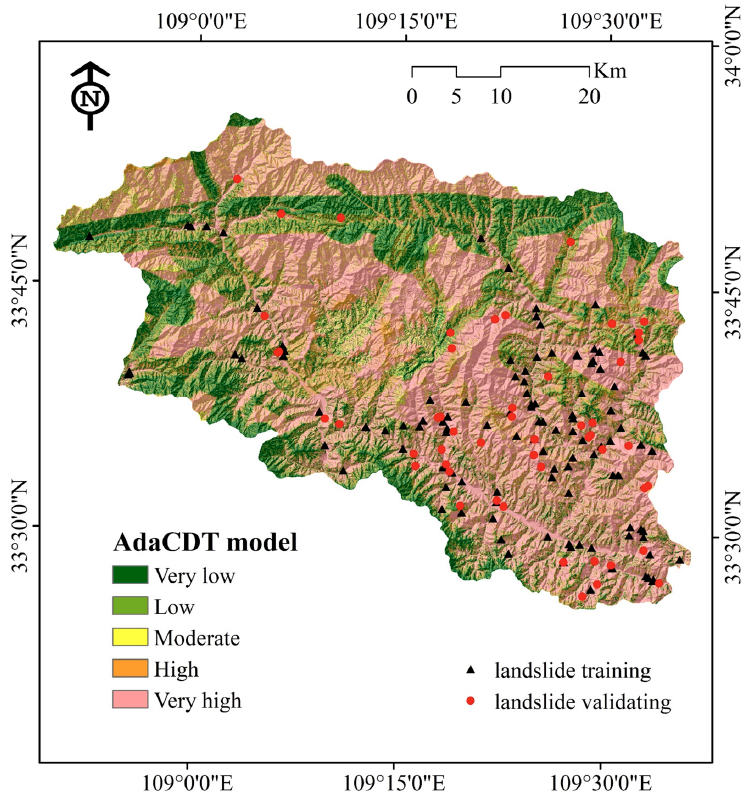
Figure 8. Landslide susceptibility map using the AdaCDT model.